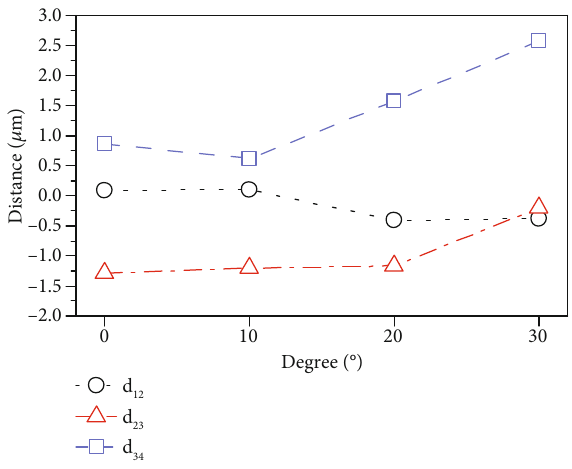
Figure 14: Variation in relative position.